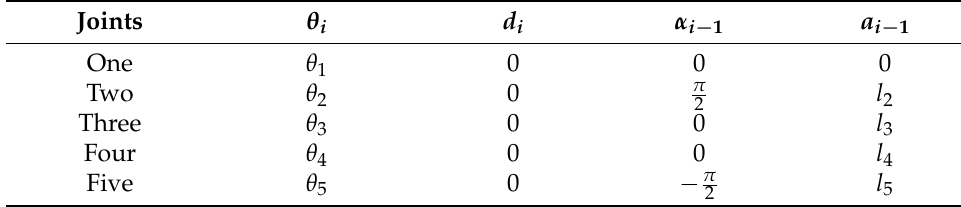
Table 2. mD-H parameters for the 5DoF robotic